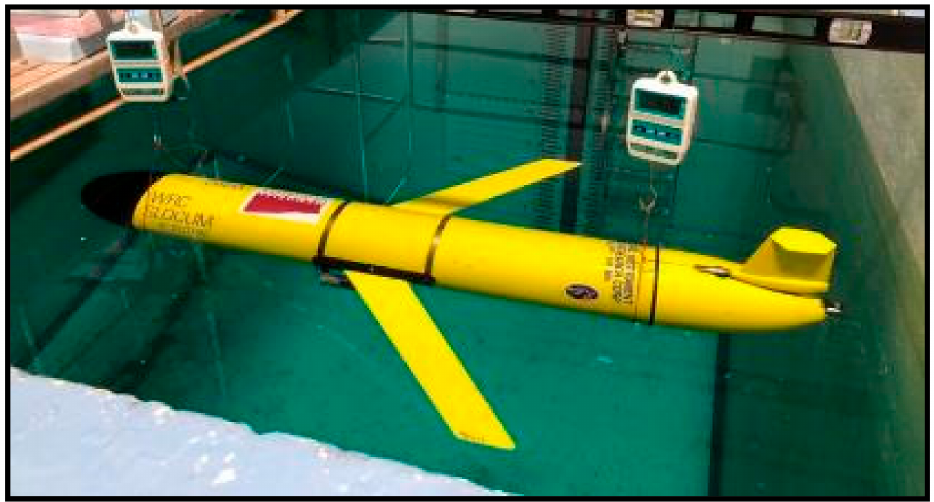
Figure 2. Slocum G1